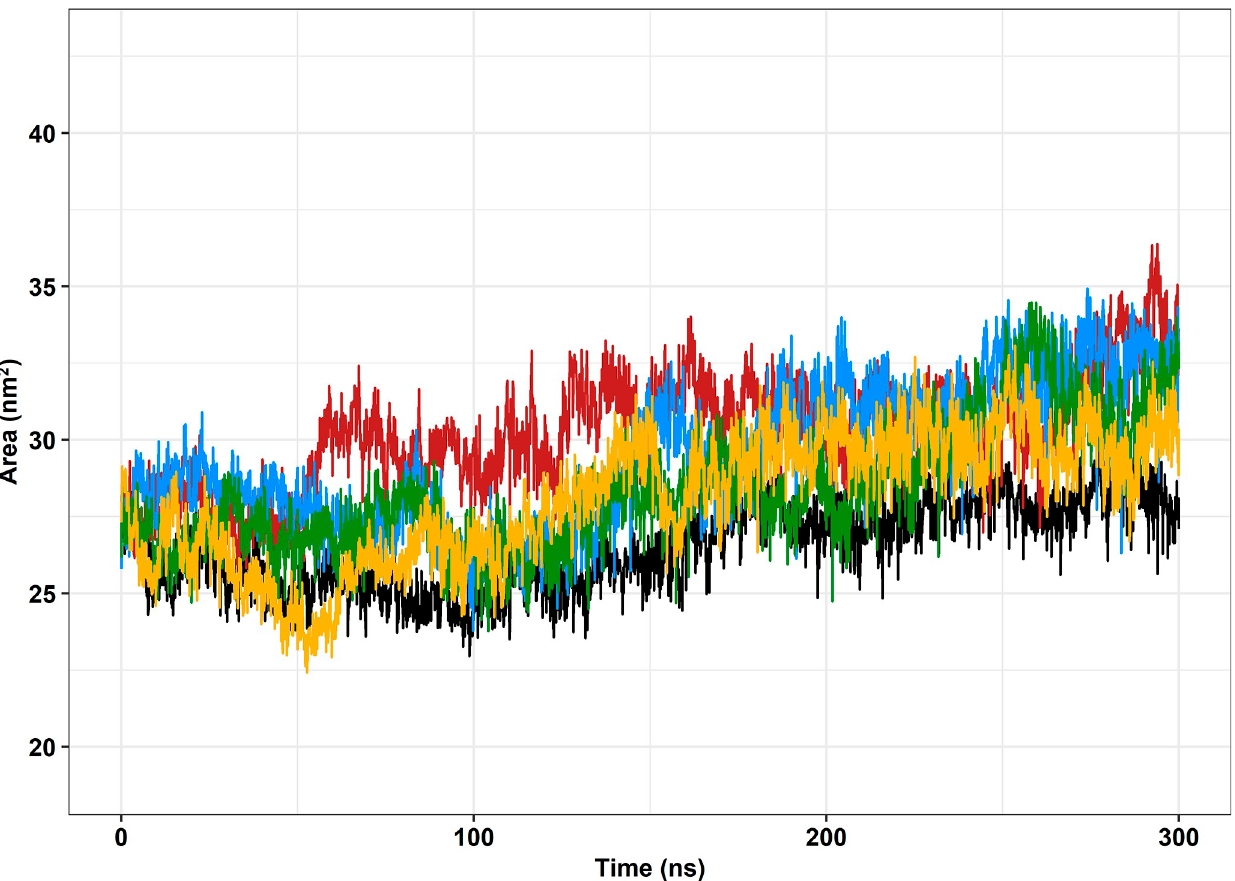
Fig 7. Solvent-accessible surface area (SASA) of the protein as a function of time. The wild-type FUS protein is represented in black, variant R521C is represented in blue, variant 521H is represented in green, variant P525L is represented in red, and variant P525L-PDB [ID: 7CYL] is represented in yellow.